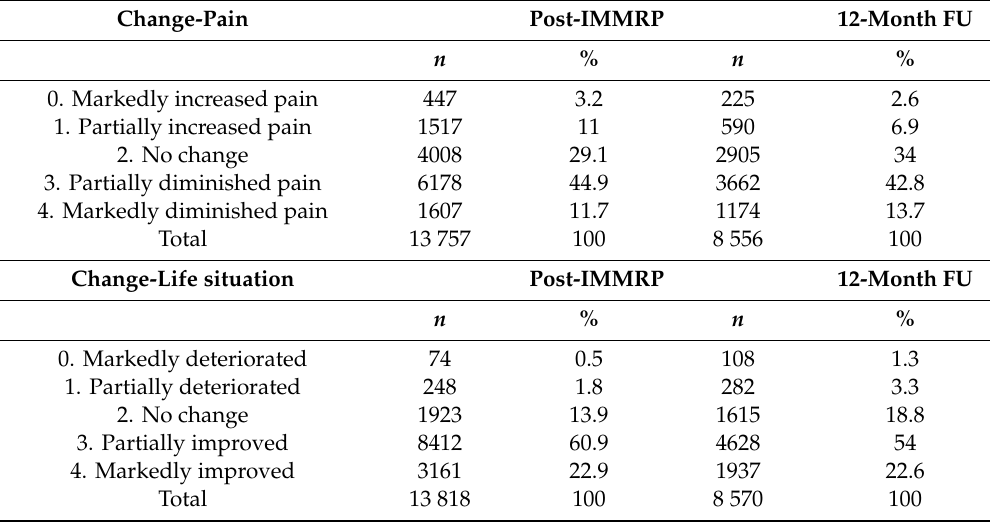
Table 4. Estimations of pain situation (Change-pain) and in the ability to handle life situation in general (Change-life situation) made immediately after IMMRP (post-IMMRP) and at the 12-month FU. Change-Pain Post-IMMRP 12-Month